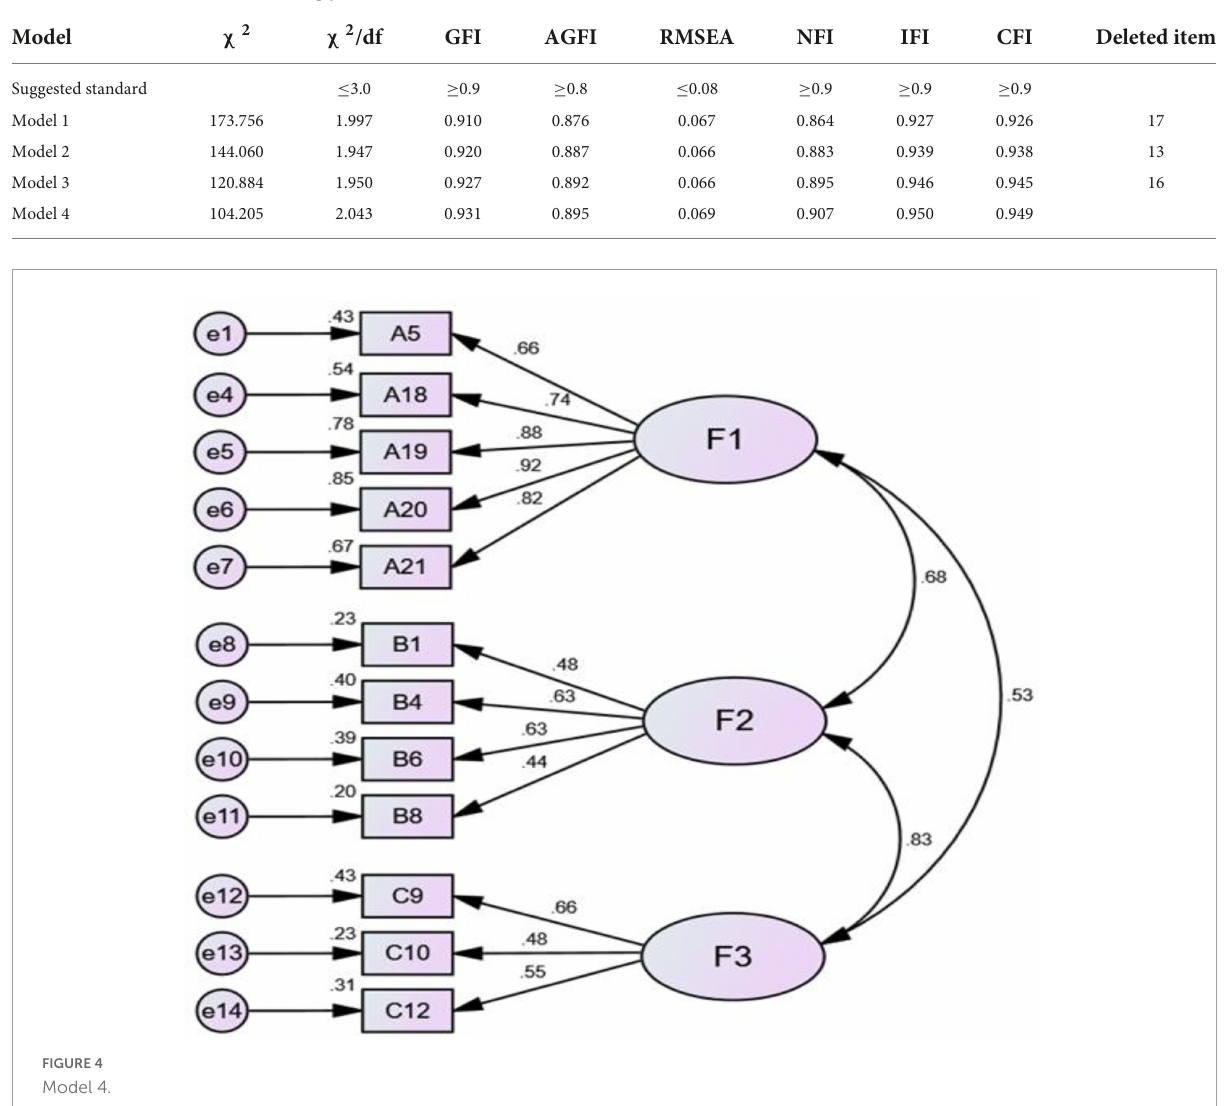
TABLE 7 Ideal model index and fitting parameters of the four models.